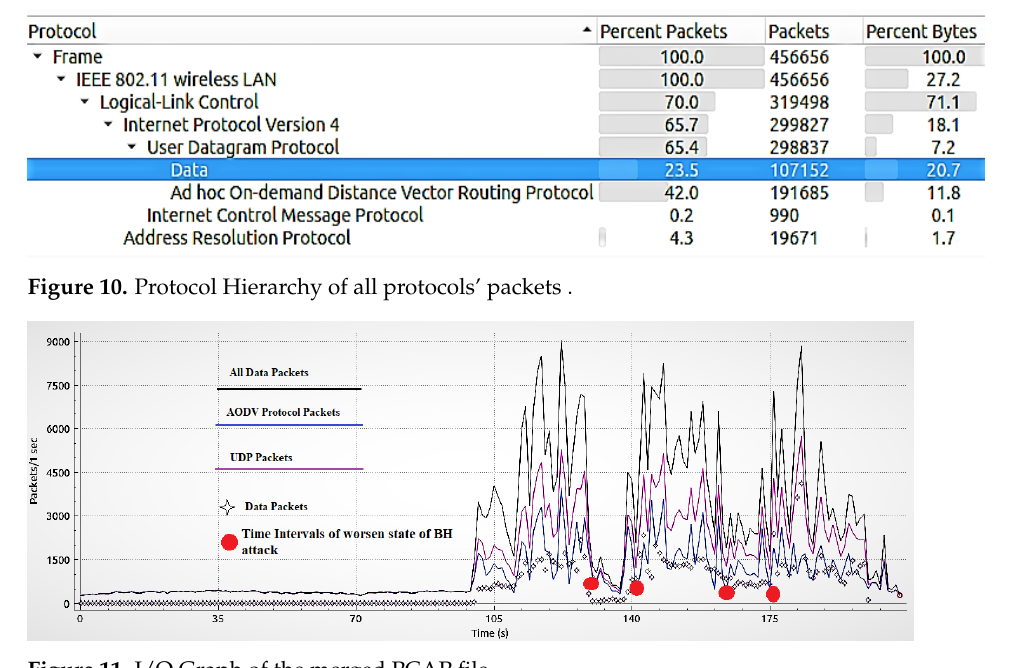
Figure 11. I/O Graph of the merged PCAP